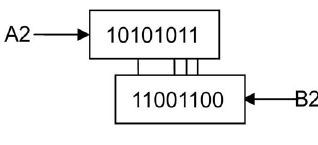
Figure 2. Example of A 2 and B 2 .